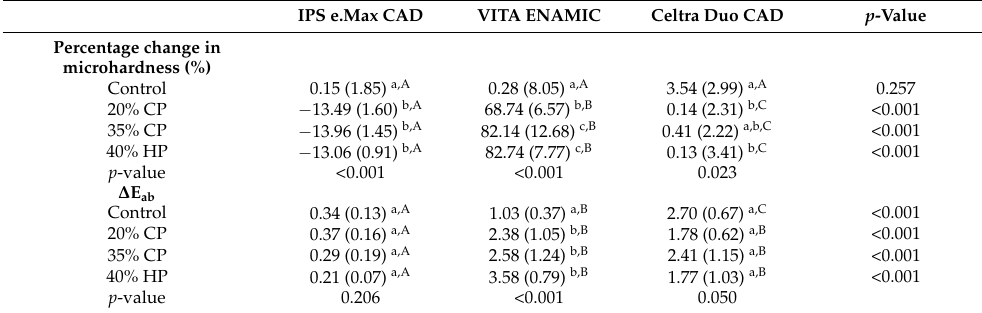
Table 2. Percentage change in microhardness (%) and ∆ E ab of different ceramic materials and bleaching groups. Values represent the mean and standard deviation (in parentheses). Similar lower case superscript letters represent non-statistically different values per column for each property. Similar superscript upper case letters represent non-statistically different values per row ( α = 0.05). CP and HP stand for carbamide peroxide and hydrogen peroxide, respectively. IPS e.Max CAD VITA ENAMIC Celtra Duo CAD p